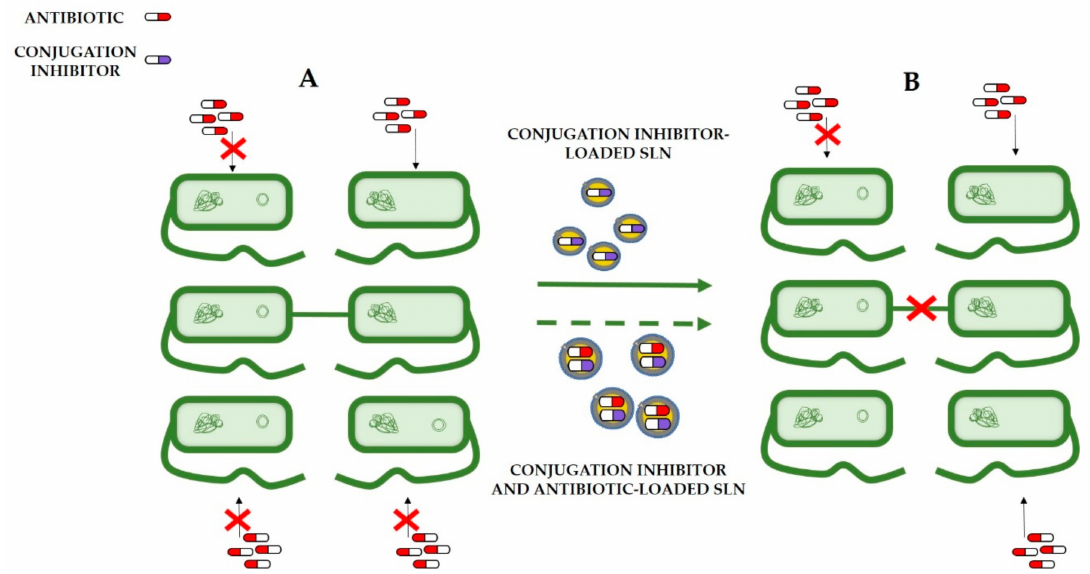
Figure 6. Schematic representation of ( A ) antibiotic resistance spreading by bacterial conjugation. At the beginning of the process, the bacterium at the left is resistant to antibiotics, but the right is not. After conjugation, both bacteria are resistant because they have shared the resistance genes coded in the plasmid (circular DNA). ( B ) Antibiotic resistance spreading inhibition (continuous line) and antibiotic resistance spreading inhibition in combination with antibiotic treatment (dashed line). Administration of conjugation inhibitors loaded into SLNs can prevent the conjugation process, avoiding resistant gene spreading. Additionally, the administration of conjugation inhibitors and antibiotics in the same SLNs treatment of the infection and inhibition of antibiotic resistance spread could be